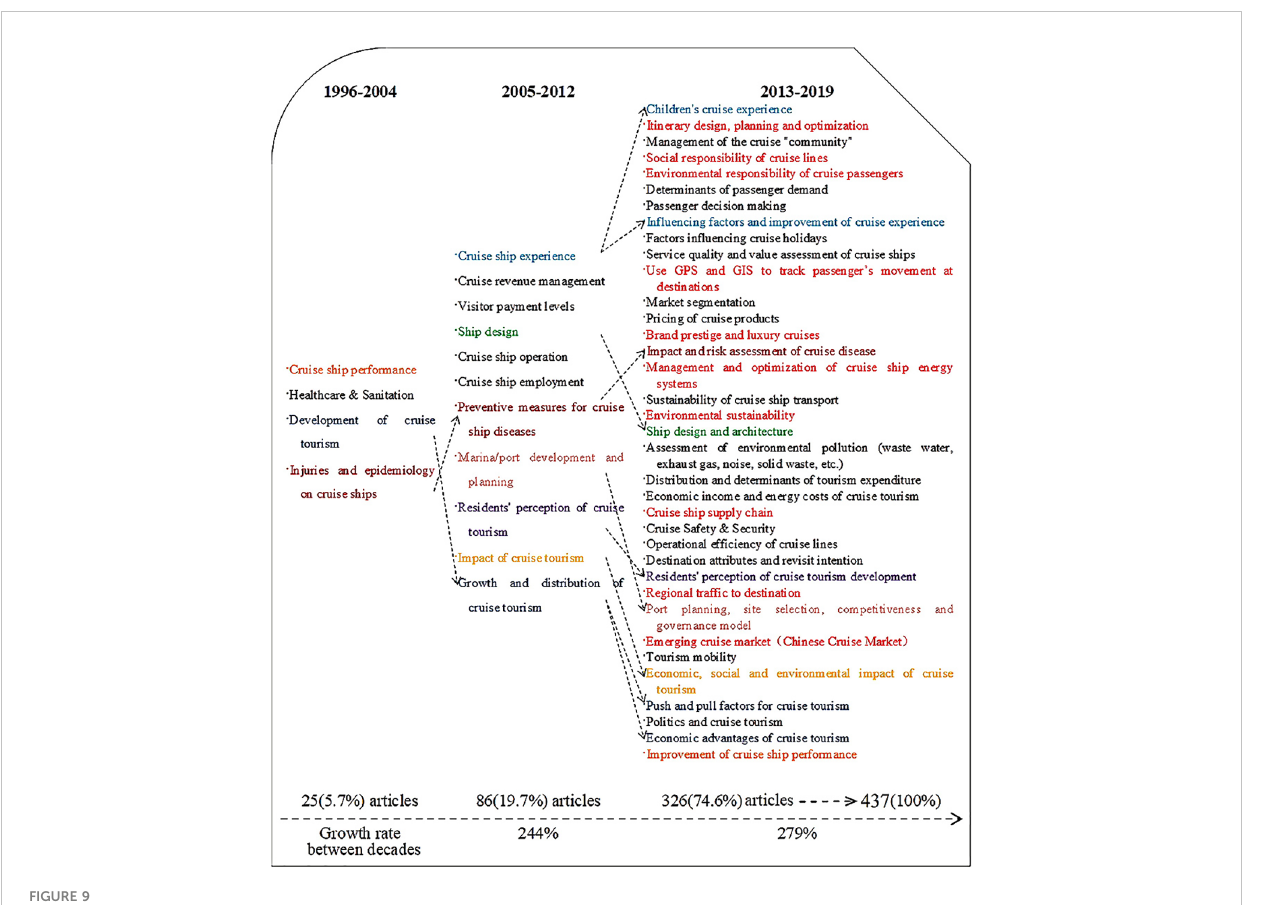
FIGURE 9 The evolution of hot spots in cruise